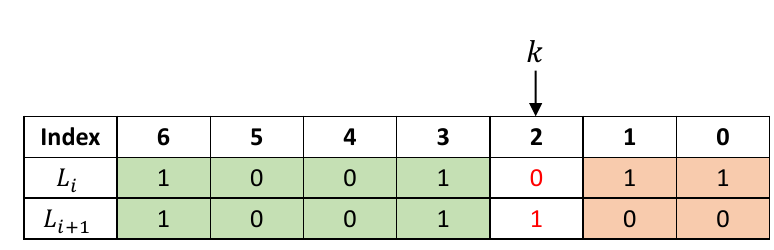
Figure 7: Example of L i and L i +1 input